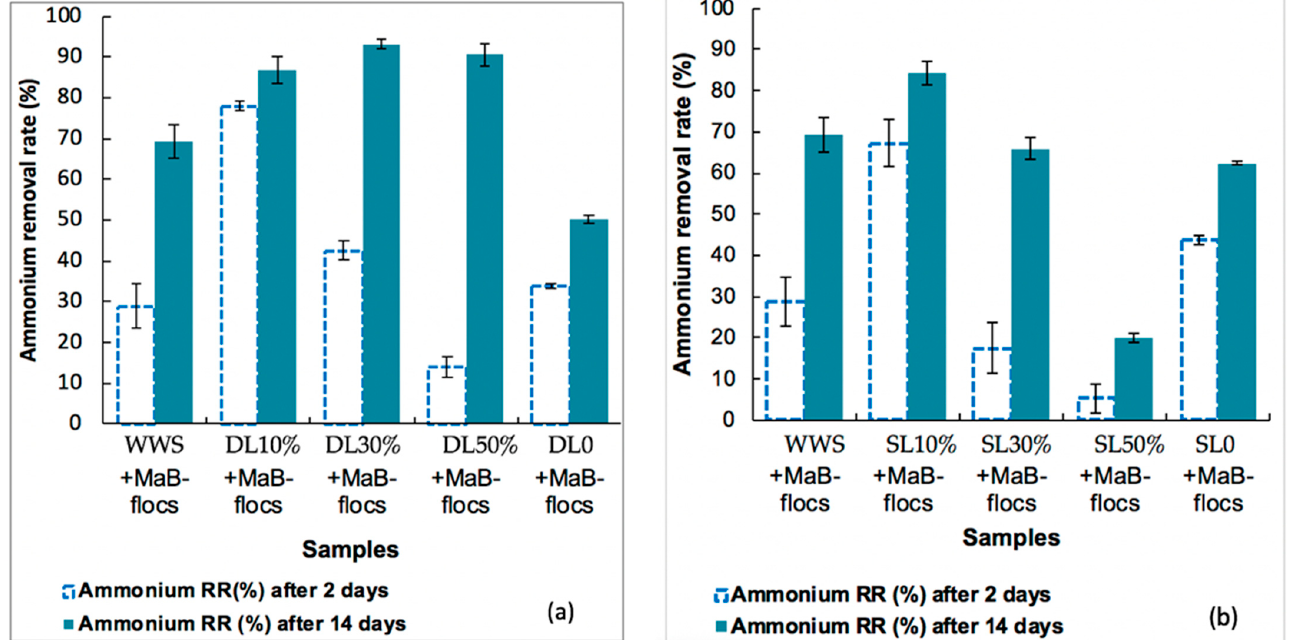
Figure 1. Ammonium removal rates (mean value ± SD) evaluated after 2 and 14 days of Ma-B flocs culture for each diluted substrate ( a ) DL: Liquid Digestate; ( b ) SL: Liquid Slurry. WWS is a synthetic wastewater control.